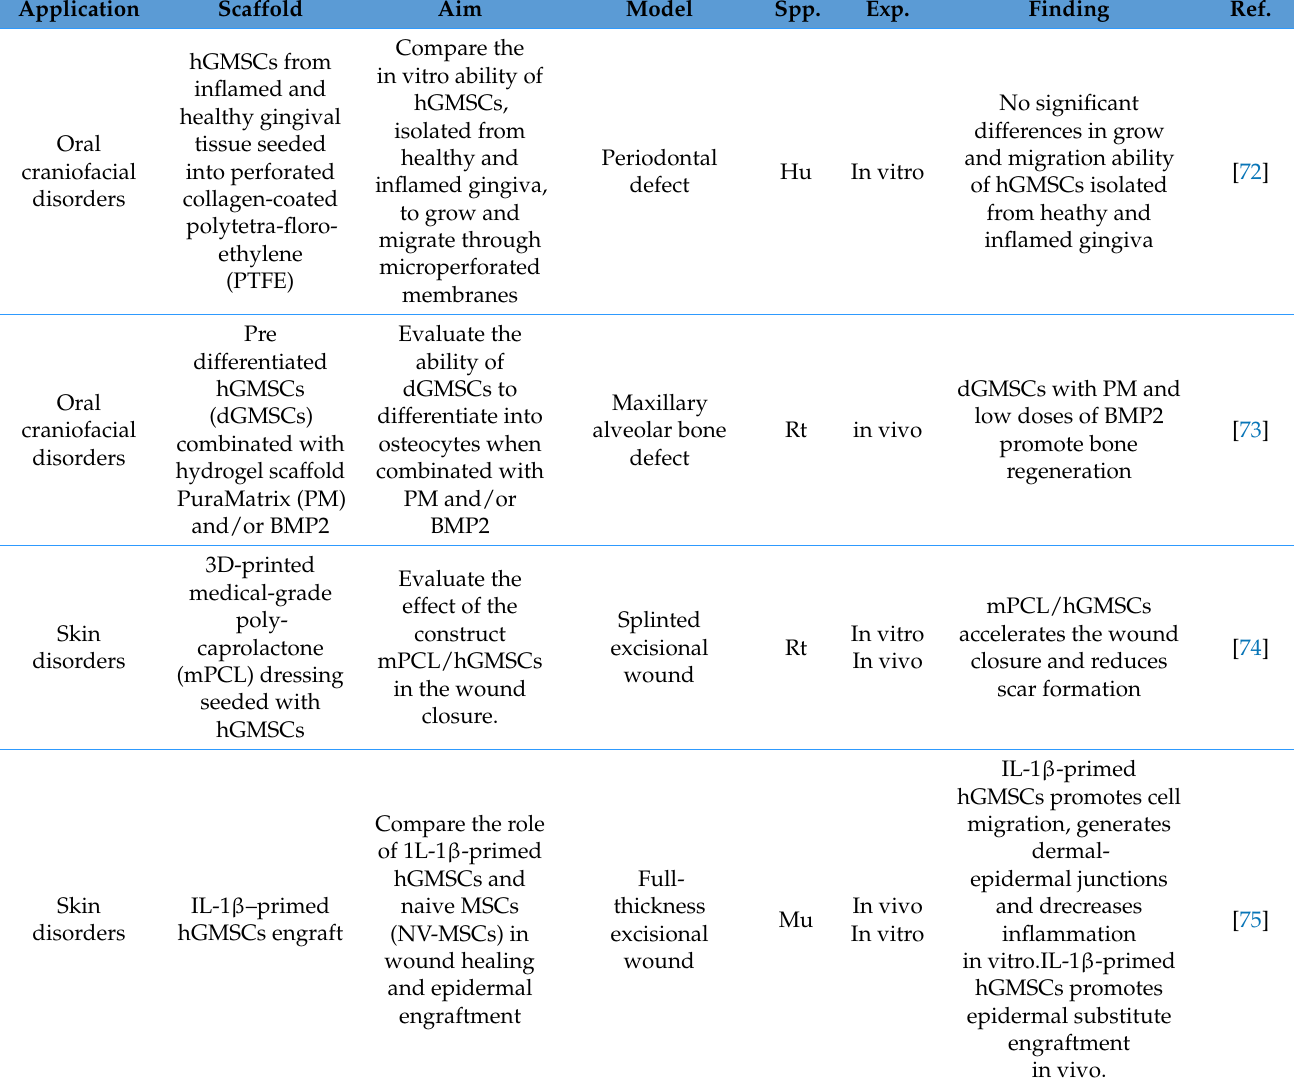
Table 5. hGMSCs application in regenerative medicine.